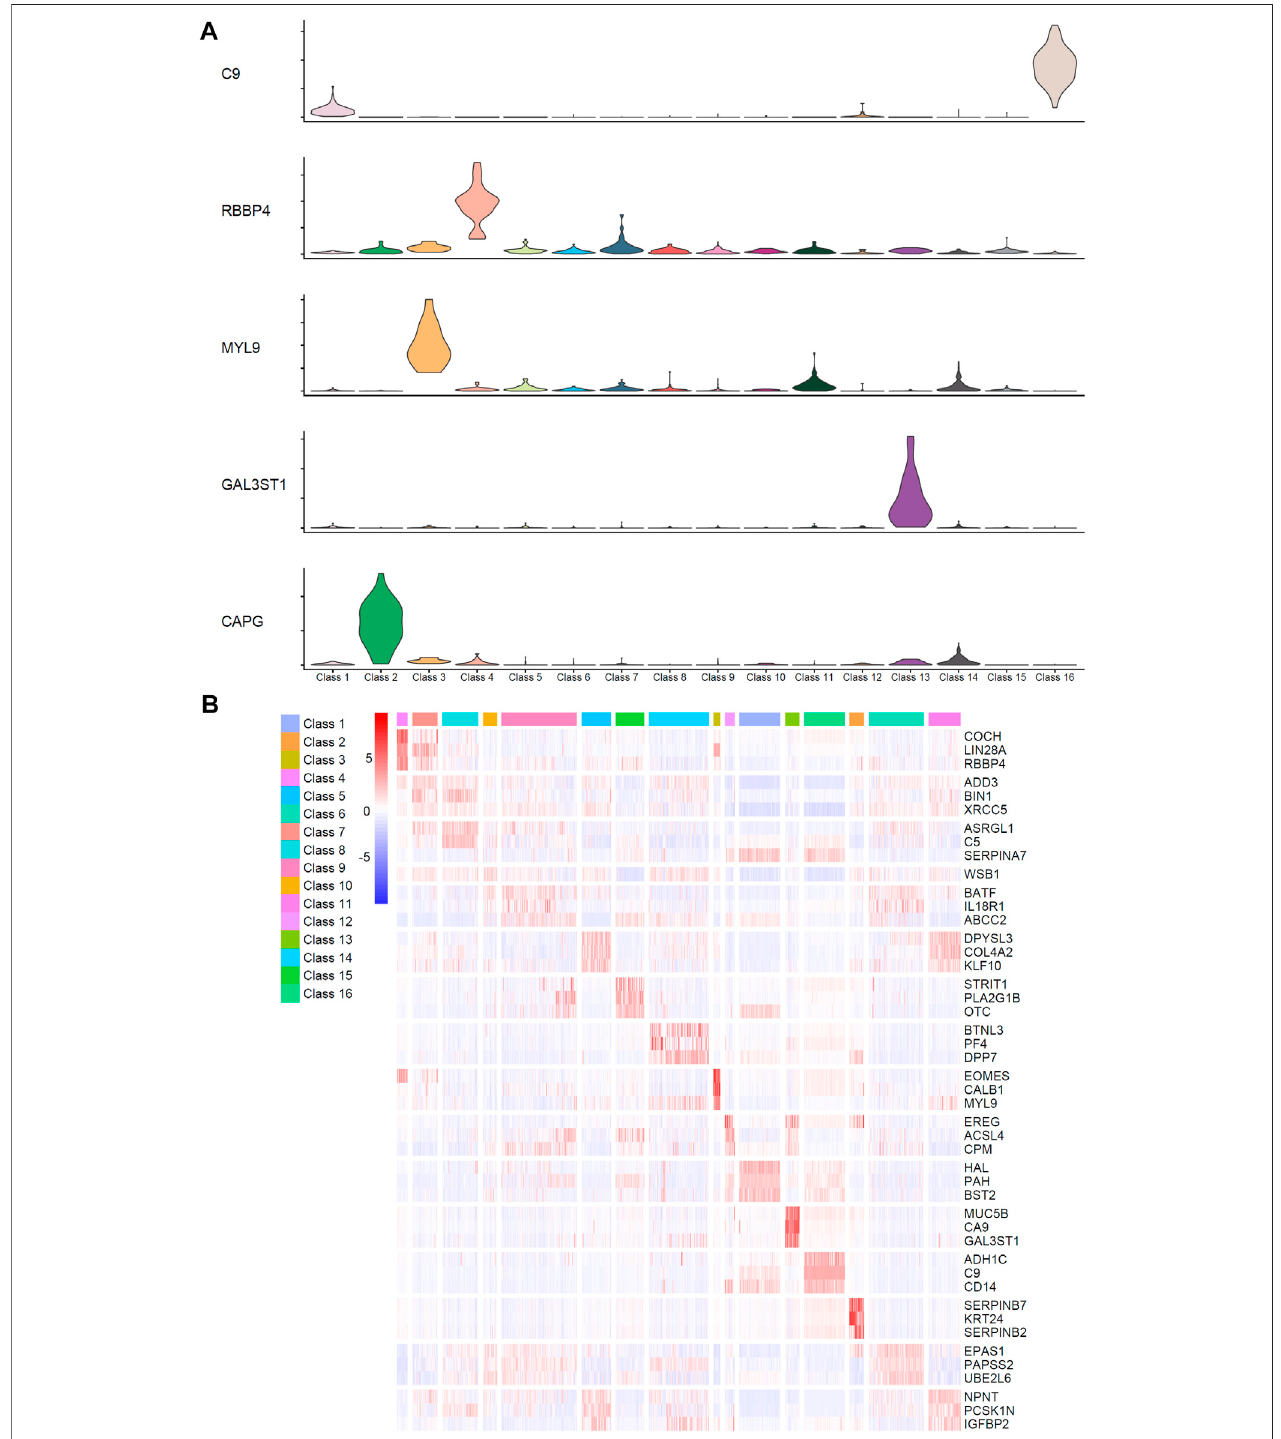
FIGURE6| Identi fi edexpression patternsofhighlyrankedgenesamongdifferentclasses. (A) Theviolinplotof fi veidenti fi edgenes, C9 , RBBP4 , MYL9 , GAL3ST1 , and CAPG ,whichhavesigni fi canthighexpressionlevelinspeci fi cclasses. (B)